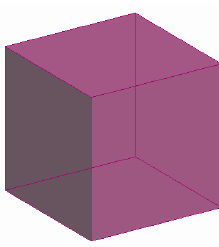
Figure 8. A cube (D4R), consisting of 6 four-membered rings (a tertiary building unit) [compiled by the authors].